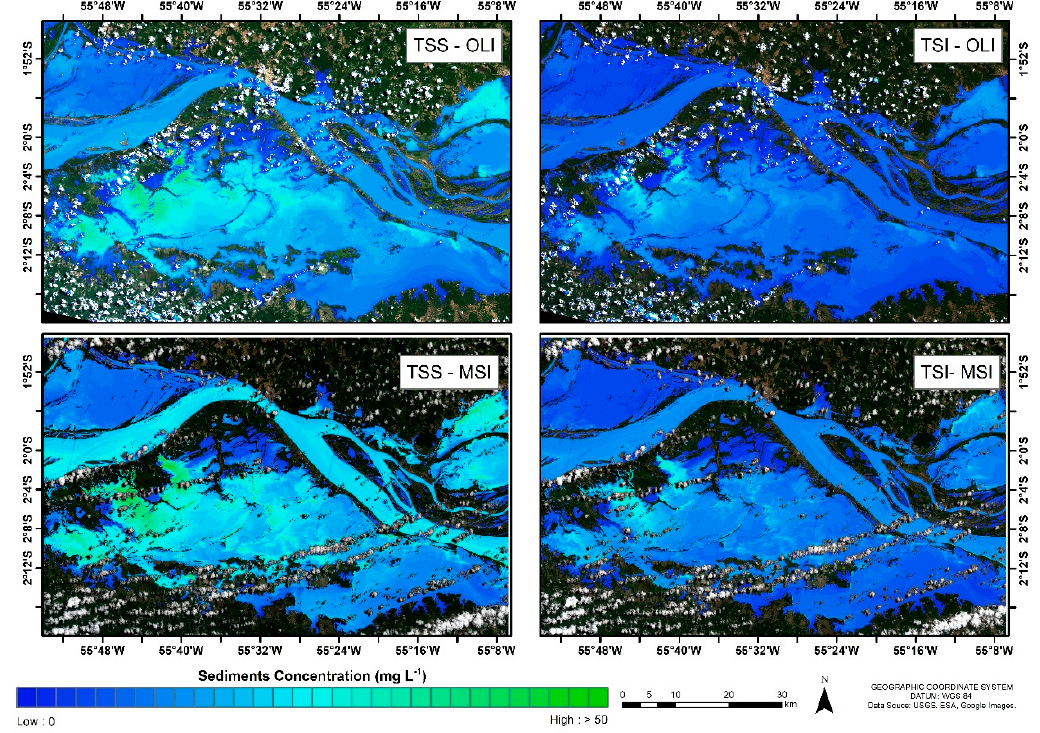
Figure 13. The TSS and TSI estimates through the ln (R rs,OB3_L8SR_deglint ) and ln (R rs,OB3_ACO_deglint ) models for TSS and TSI, respectively, using OLI images and for the ln (R rs,MB5_6S_deglint ) models for TSS and